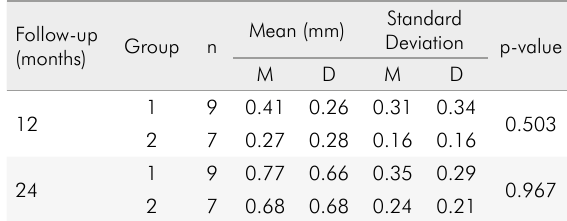
Table 2. Bone loss pattern in group 1 (n = 9 implants) and group 2 (n = 7 implants). Implants from T0 (implant